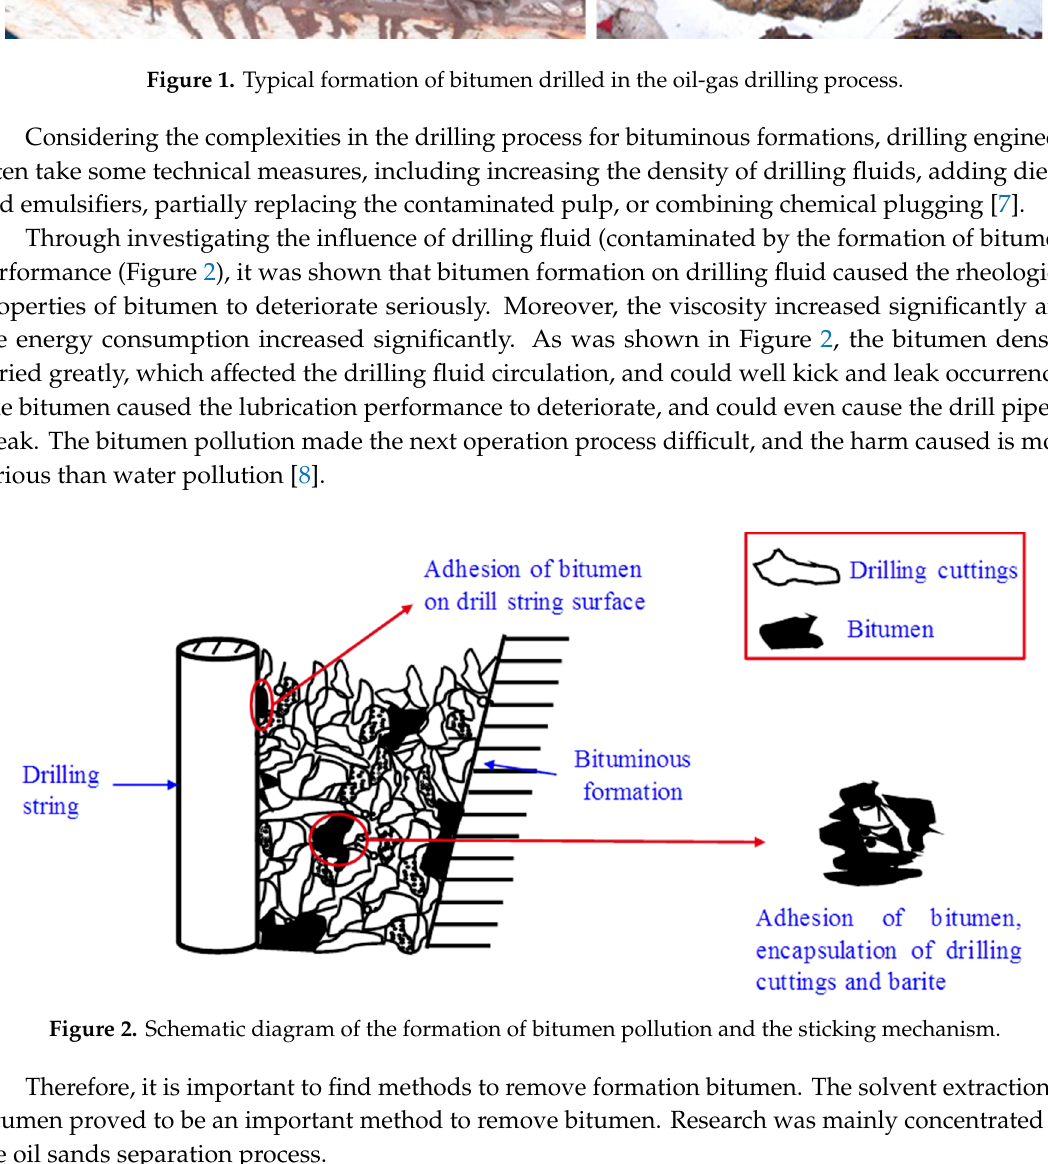
Figure 2. Schematic diagram of the formation of bitumen pollution and the sticking mechanism.